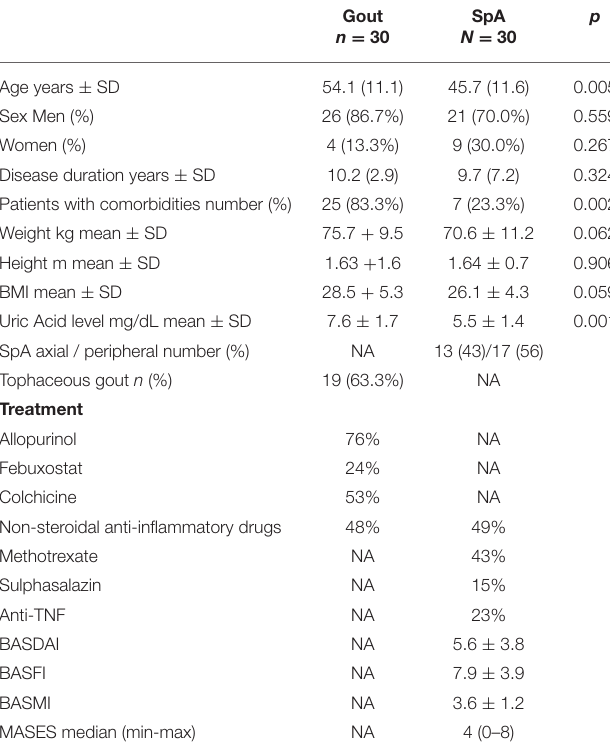
TABLE 1 | Clinical and demographics characteristics among groups. TABLE 2 | Comparison of US findings of entheses between